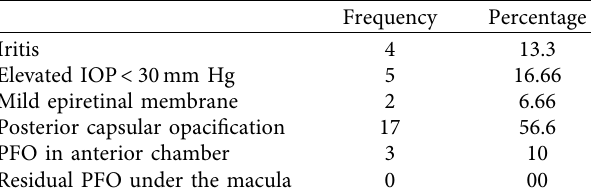
Figure 1: BCDVA change overtime. Table 3: Postoperative